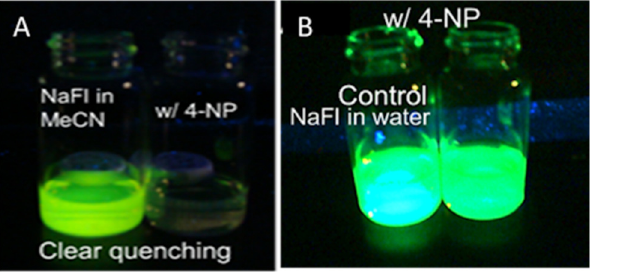
Figure 8. The fluorescence emission of NaFl under UV lamp in MeCN ( A ) and water media ( B ) when 4NP was added.